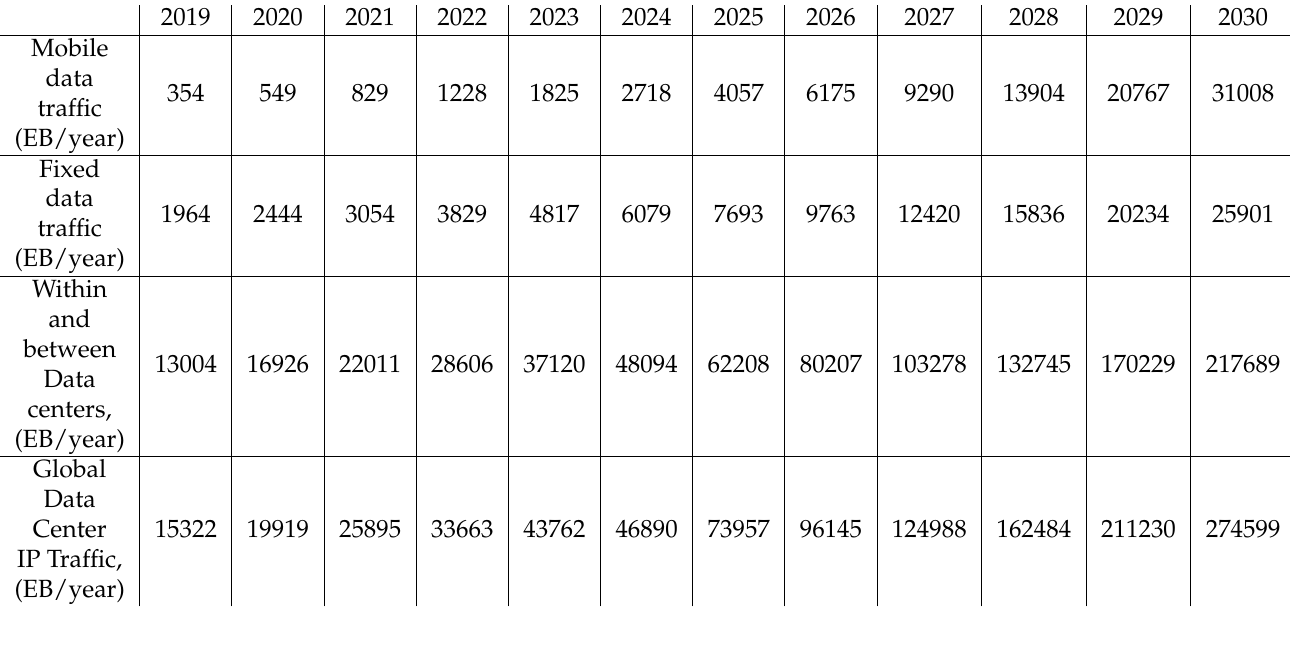
Table 21. Effect of Internet handprint on global GHG supply from 2019 to